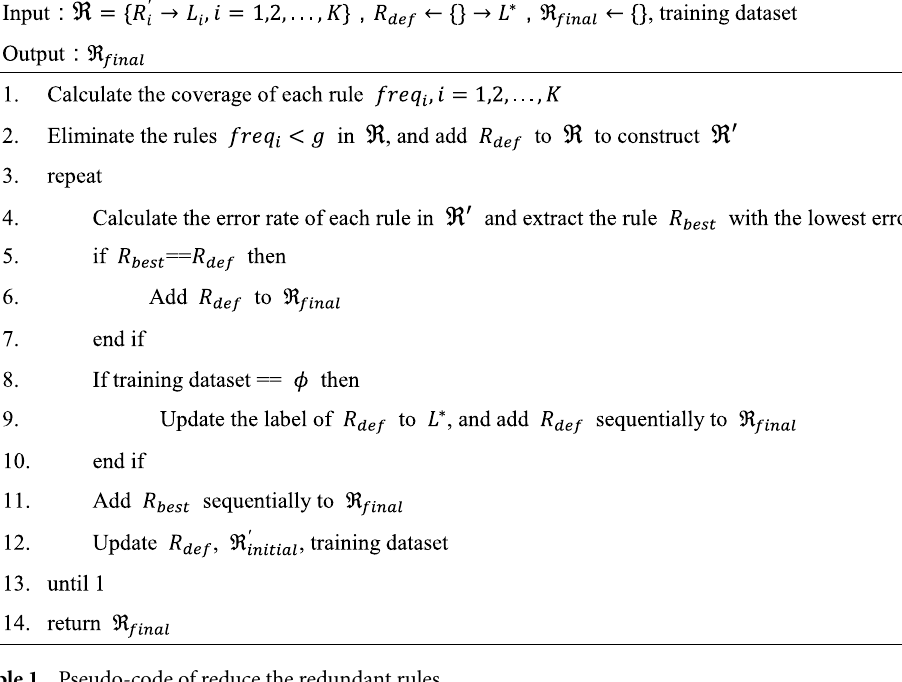
Table 1. Pseudo-code of reduce the redundant